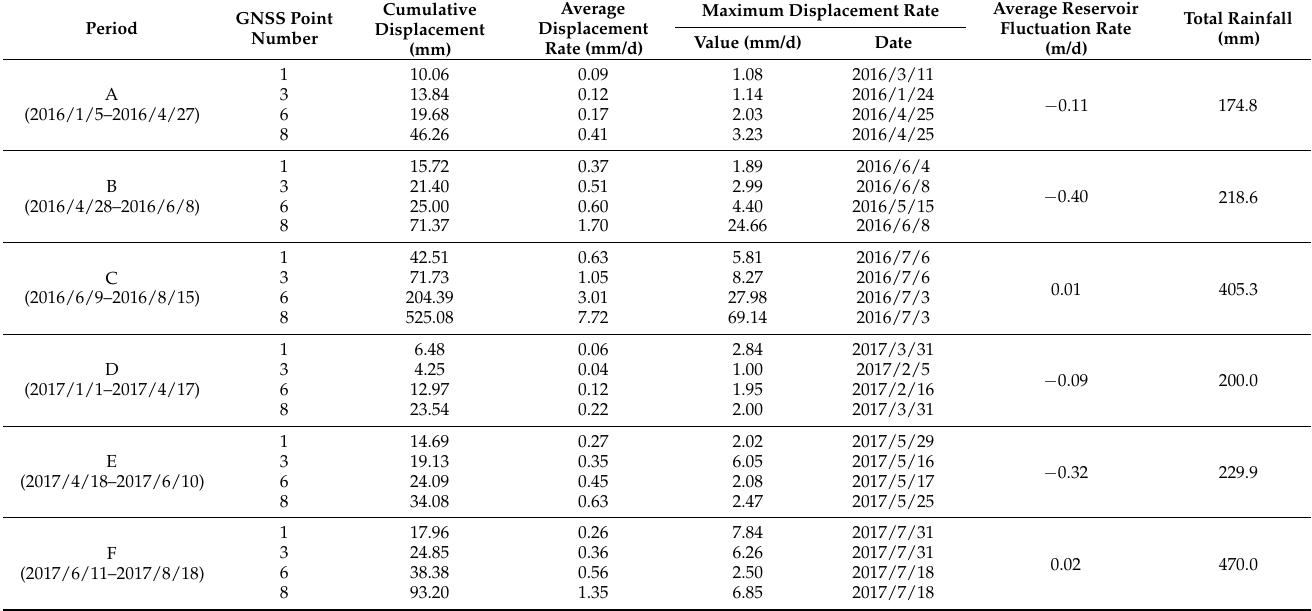
Table 4. Statistics of landslide displacement, reservoir water level, and rainfall from 2016 to